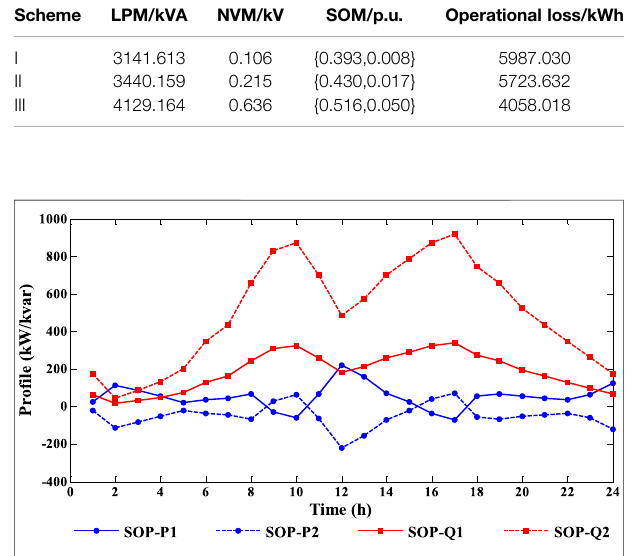
FIGURE 11 | Operation analysis diagram of SOP.